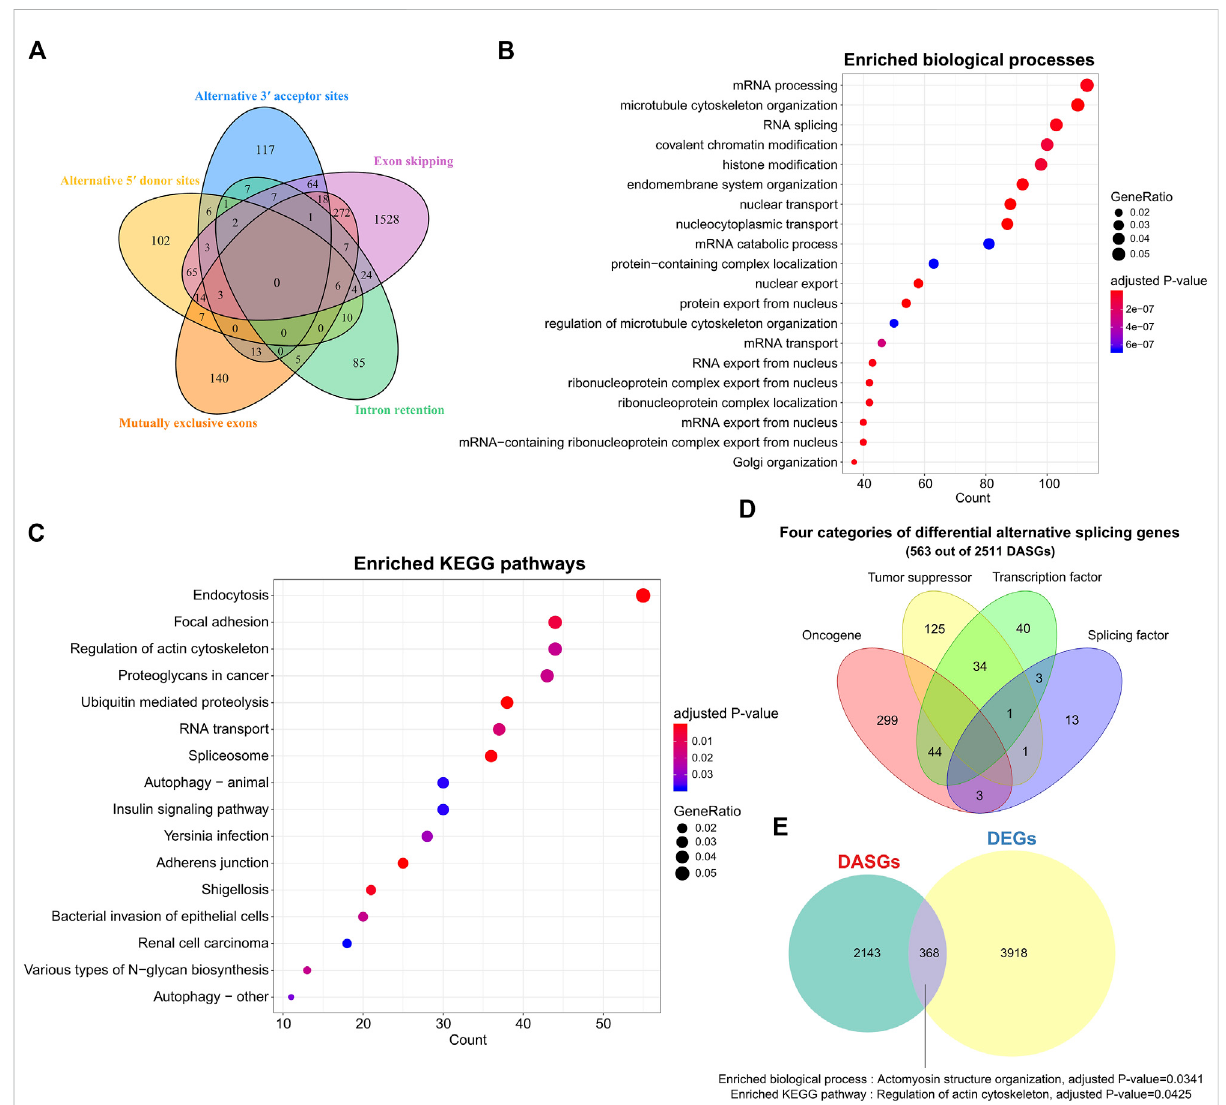
FIGURE 2 Alternative splicing patterns and related gene functions of SS. (A) Venn plot of the DASGs for fi ve common splicing modes. (B) Top 20 enriched biological processes of DASGs. FDR < 0.05. (C) Top 20 enriched pathways for DASGs. Adjusted p -value < 0.05. (D) Distinct categories of DASGs. (E) Comparison between DEGs and DASGs. DASGs: differentially alternative spliced genes; DEGs: differentially expressed